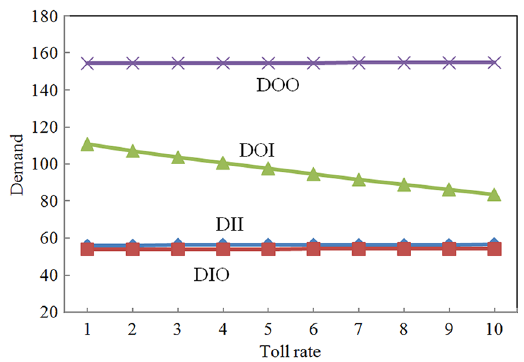
Fig. 5. Analysis of travel time under cordon pricing